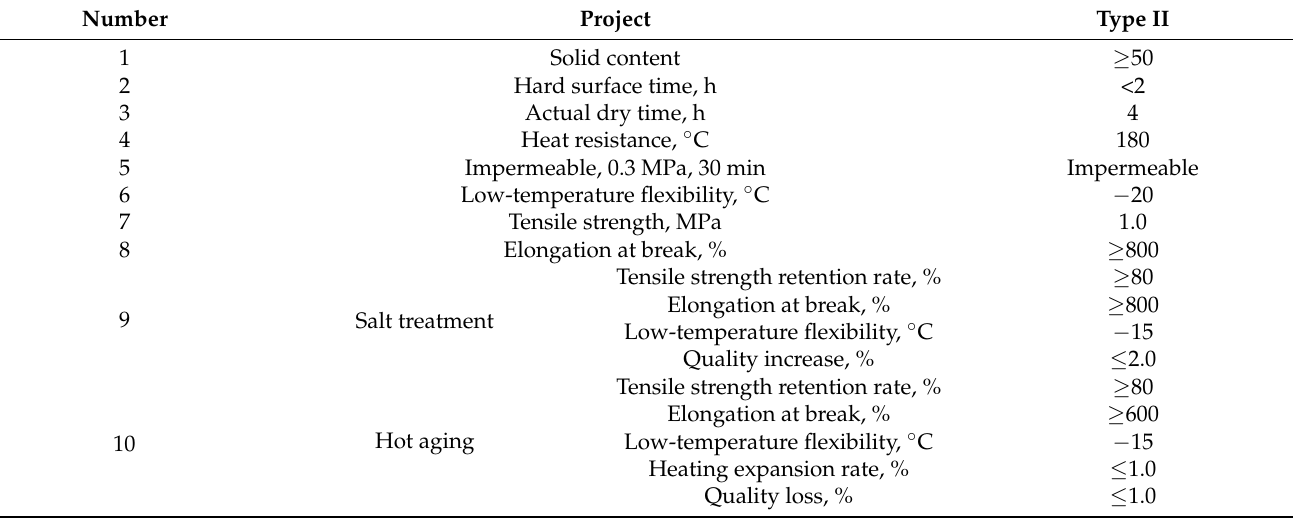
Table 5. Technical indices of polymer-modified asphalt waterproof coating.